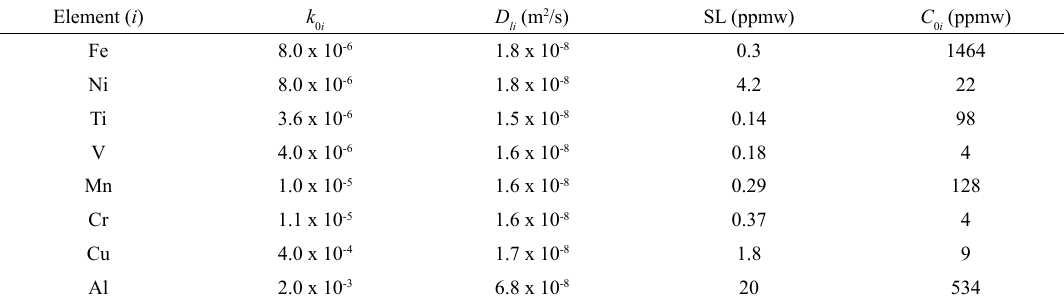
), diffusion coefficient of element i in the liquid ( D ), 0 i li ) used in the experiment. 0 i